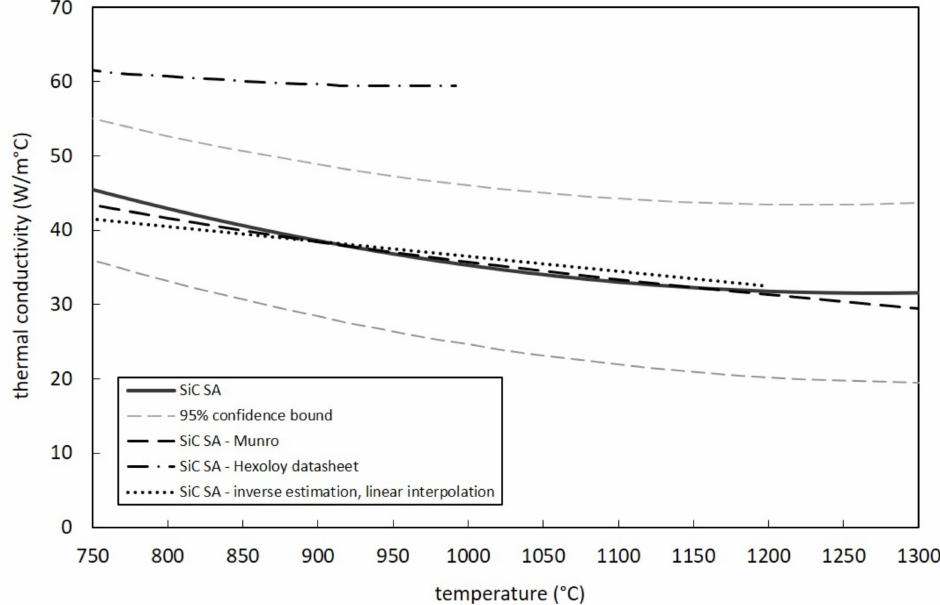
Figure 11. Measured thermal conductivity values for SiC SA samples and comparison with data ob- tained by Munro [19], Hexoloy ® datasheets [25] and the inverse estimation (with linear interpolation) by Manzolaro et al. [15].